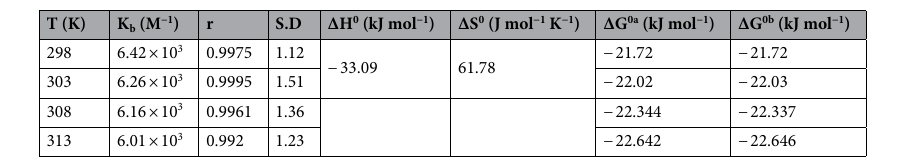
Table 2. Assessment of the binding constants (K b ) at four different temperatures and thermodynamic parameters of the CT-DNA-PLB complex. a Δ G 0 = RT ln K b . b Δ G 0 = Δ H 0 − T Δ S 0 .